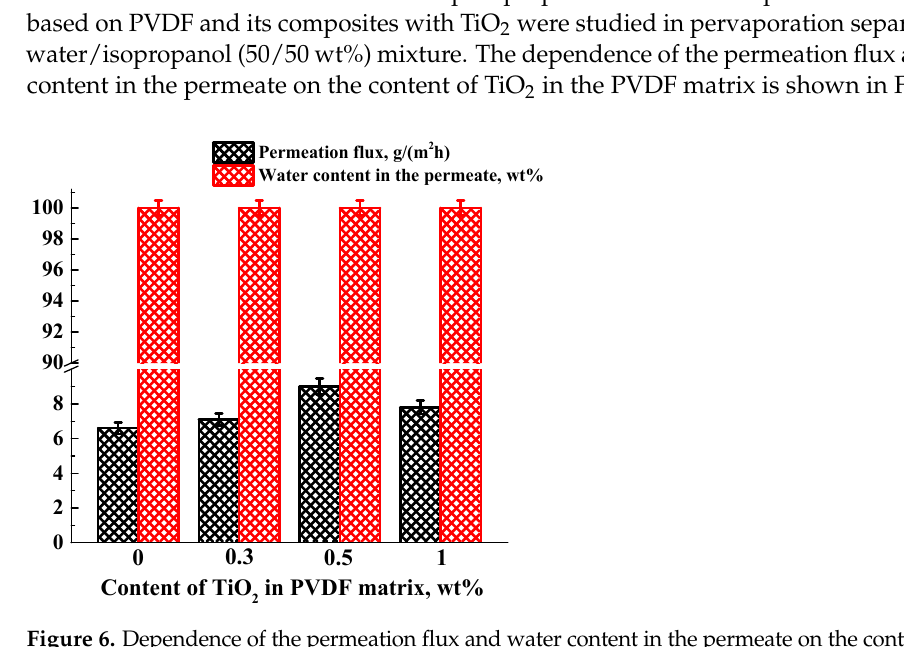
Figure 6. Dependence of the permeation flux and water content in the permeate on the content of TiO 2 in the PVDF matrix in pervaporation separation of a water/isopropanol (50/50 wt%) mixture at 22